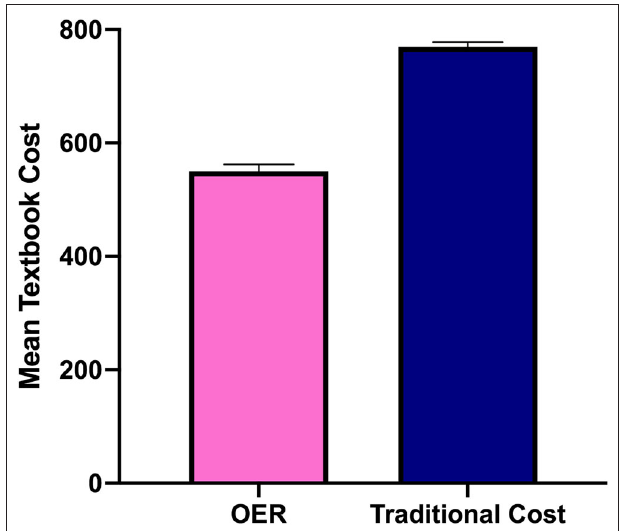
FIGURE 1 | Mean number of target courses selected between OER and Traditional Cost